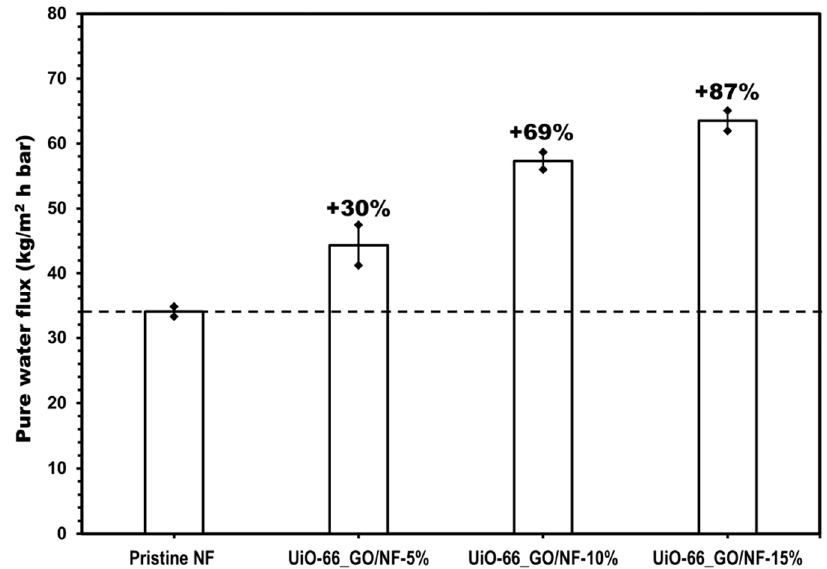
Figure 5. Pure water flux of pristine and composite membranes (operation pressure = 4 bar; solution pH = 5). Plots and error bars represent averages and standard deviations from triplicate experiments.